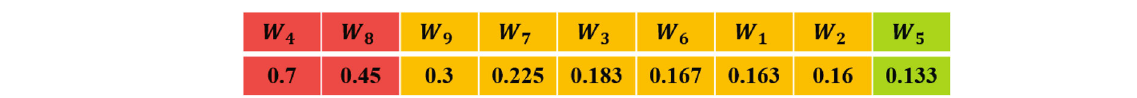
Fig. 8 The result of classification for the example showed in Fig. 6